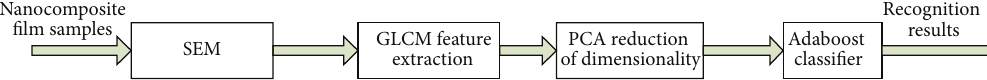
Figure 2: GABD automatic identification model of nanocomposite